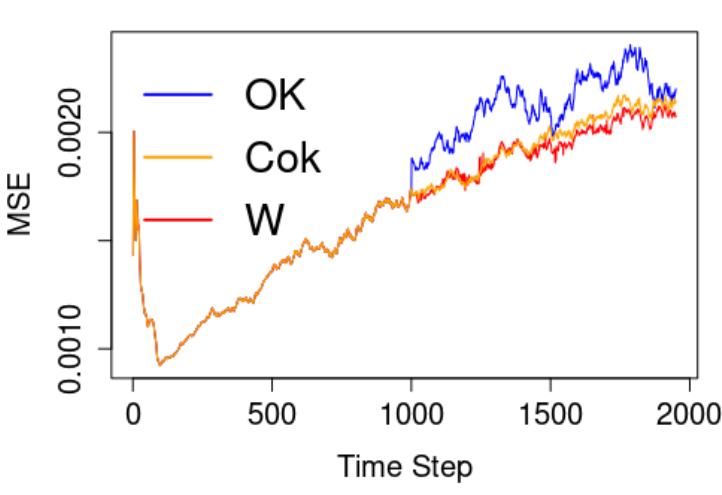
Figure 12. The MSE at each time